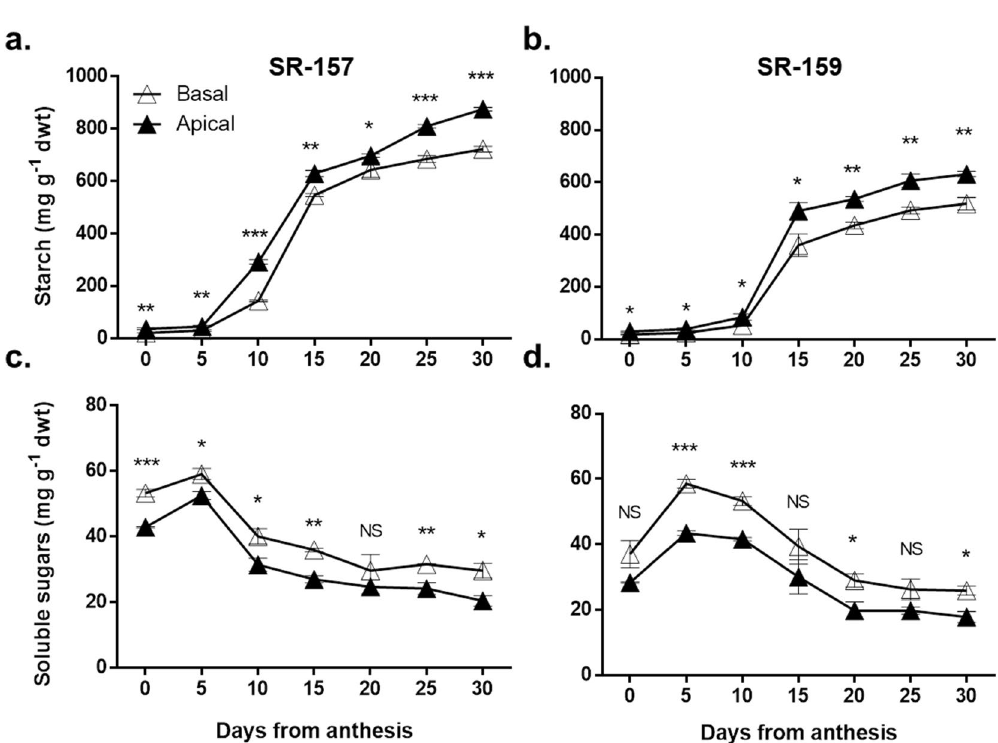
Figure 2. Starch (upper panel: a , b ) and soluble carbohydrate (lower panel: c , d ) concentration of apical (close triangle) and basal (open triangle) of spikelets during post-anthesis period from 0 to 30 days at 5 day intervals in SR-157 (left panel: a , c ) and SR-159 (right panel: b , d ). Individual data represents the mean of 3 replicates (n = 3) and vertical bars represent ± SD